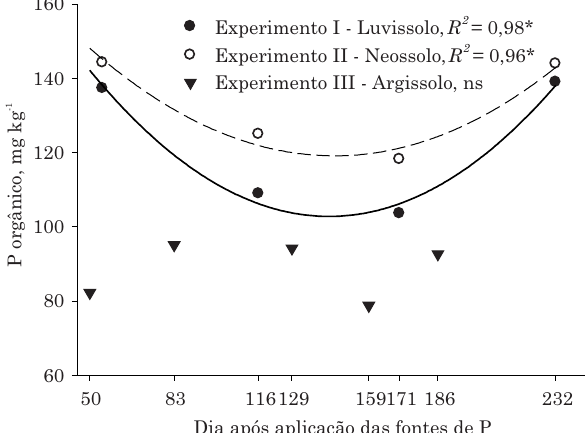
Figura 3. Variação do teor de P orgânico após a aplicação de fontes de fosfato em solos sob pastagem natural. Diferenças significativas a p<0,05 entre épocas de avaliação; e ns: não